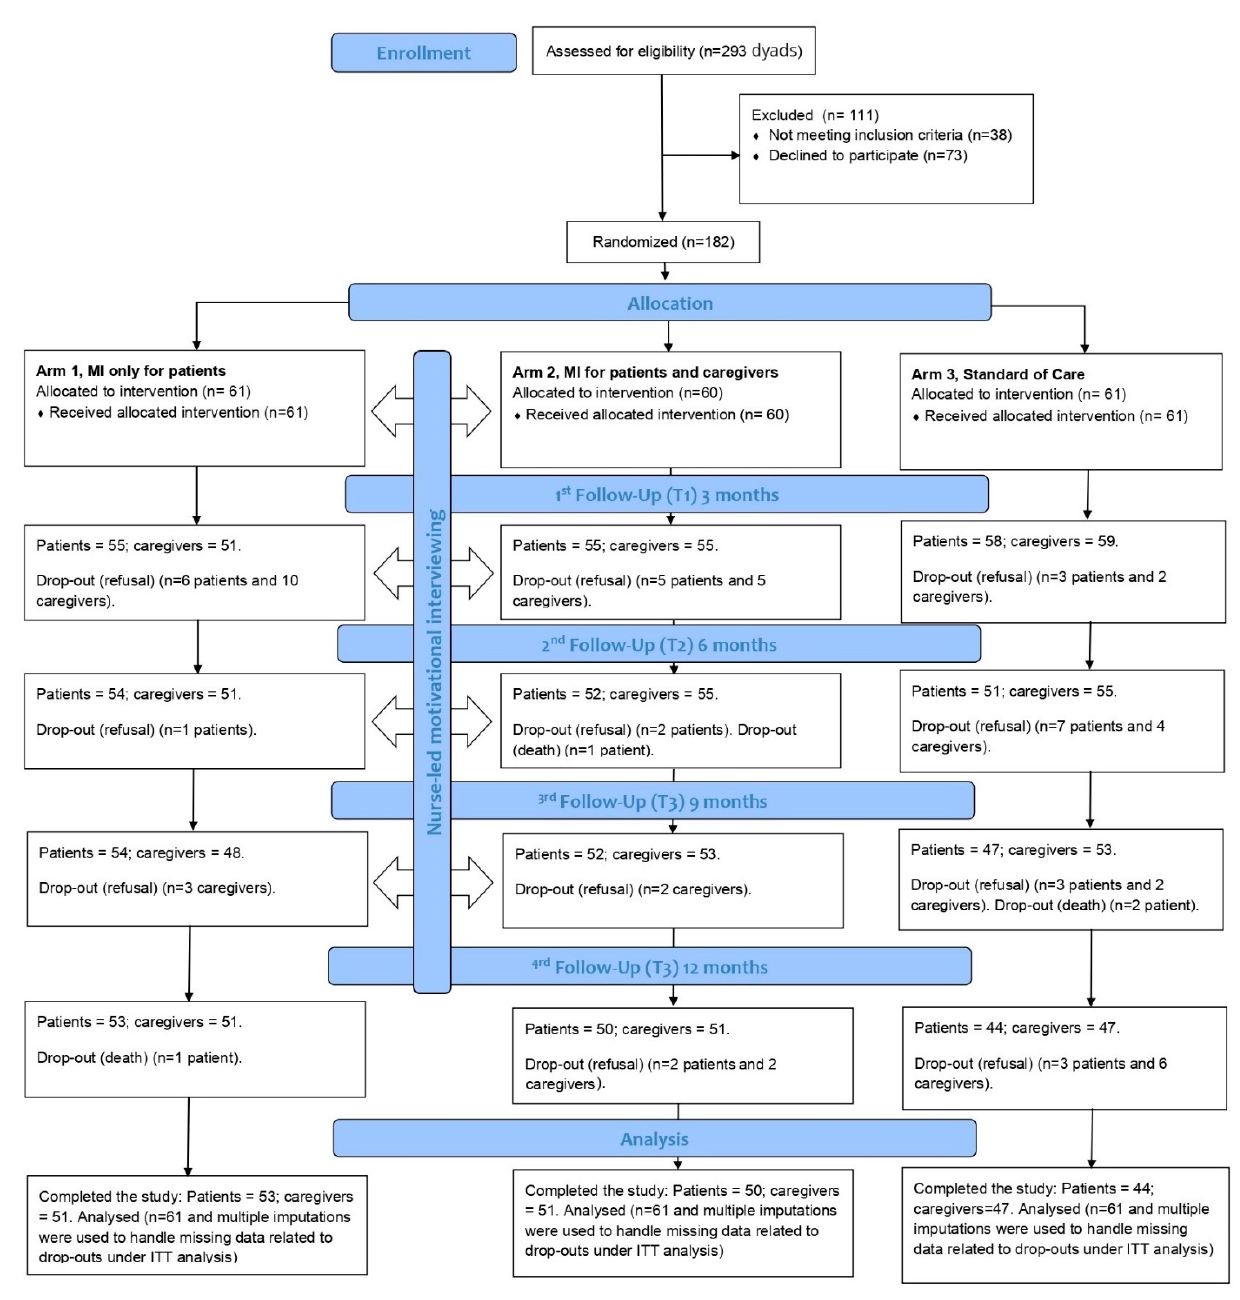
Figure 1. Patient